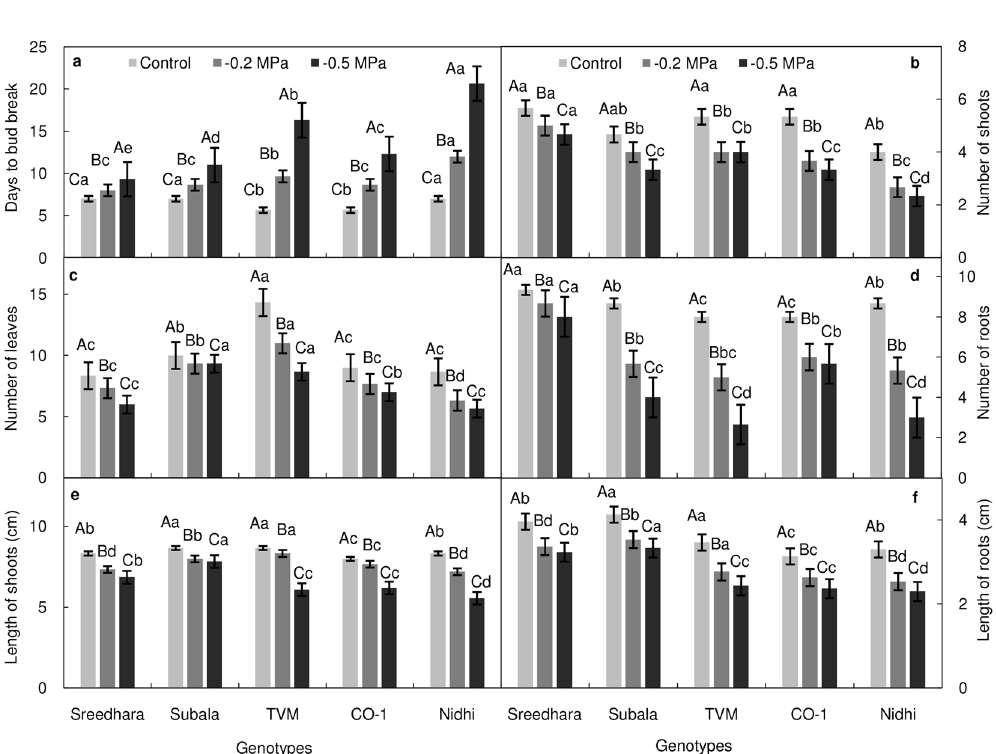
Figure 1. ( a–f ) Effect of in vitro PEG mediated osmotic stress on growth response of Chinese potato genotypes. ( a ) days to bud break, ( b ) number of shoots, ( c ) number of leaves, ( d ) number of roots, ( e ) length of shoots (cm) and ( f ) length of roots (cm). Values are the mean of three replicates and bars represent standard error of means. Different letters in upper case represent significant differences between the treatments (control, –0.2 MPa and –0.5 MPa) in the genotypes and lower case represents significant difference among the genotypes under each treatment according to Tukey’s